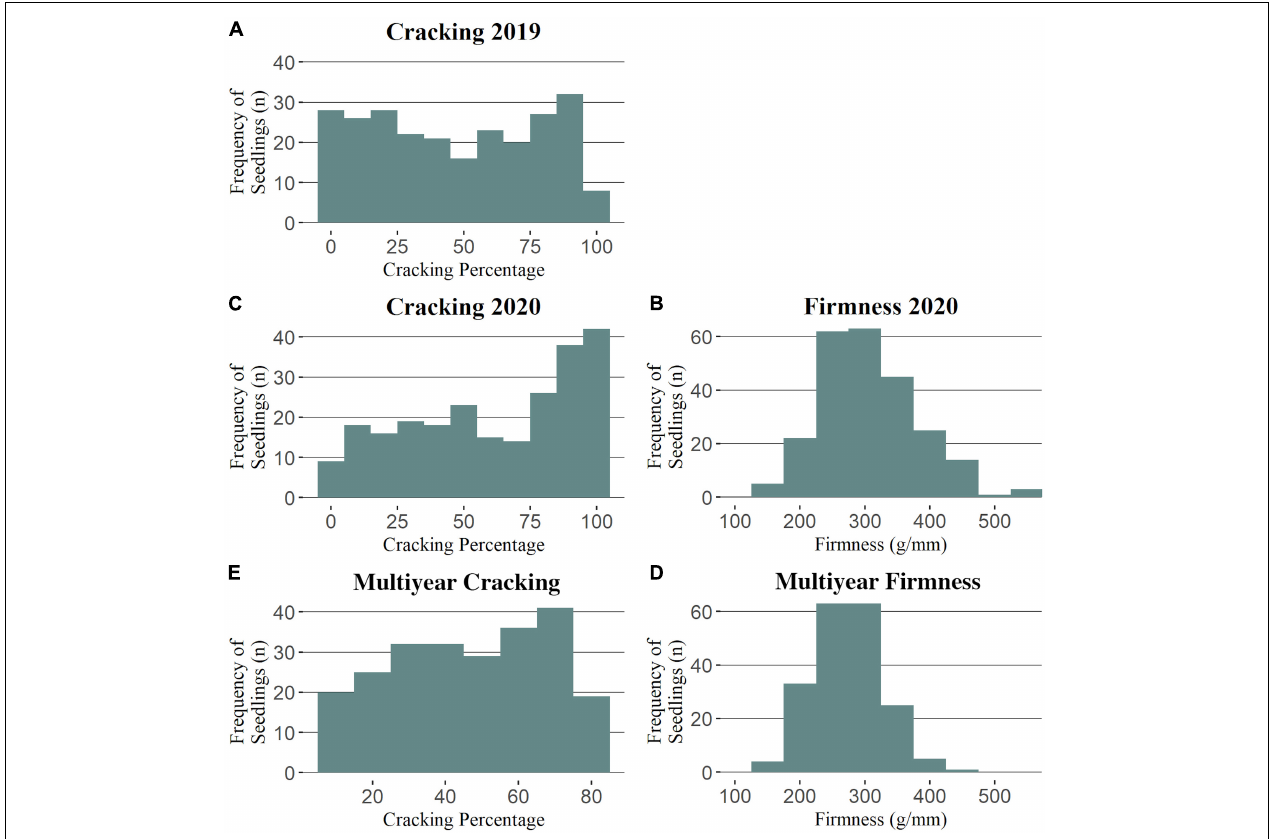
FIGURE 1 | Phenotypic trait distributions for the Combined seedling population. Distributions for cracking incidence in 2019 (A) , 2020 (C) , and multiyear (E) and for firmness in 2020 (B) and multiyear (D)